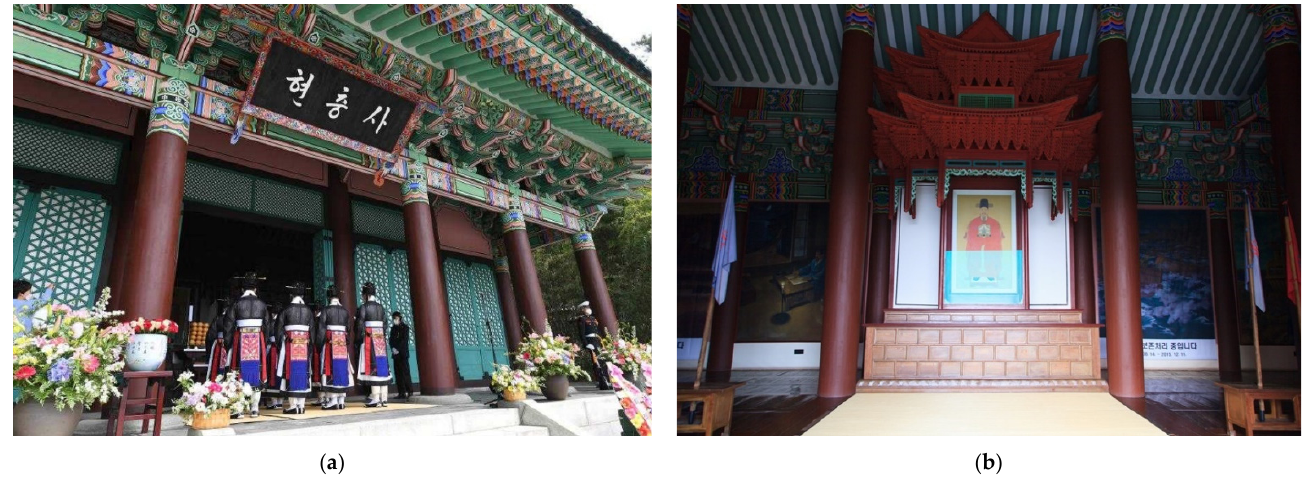
Figure 9. ( a ) Front Column Space for Worshipping ( b ) Enshrining Space (source: Cultural Heritage Administration).